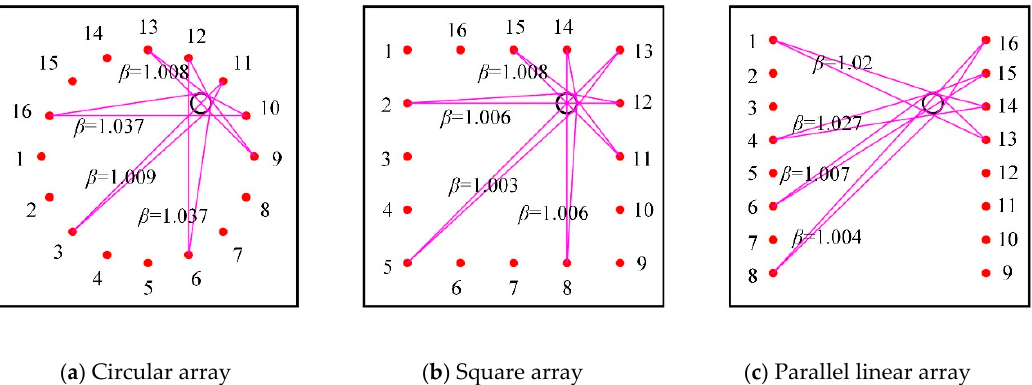
Figure 4. Variable shape factors for three PZT sensor array configurations for the specimen with a hole.